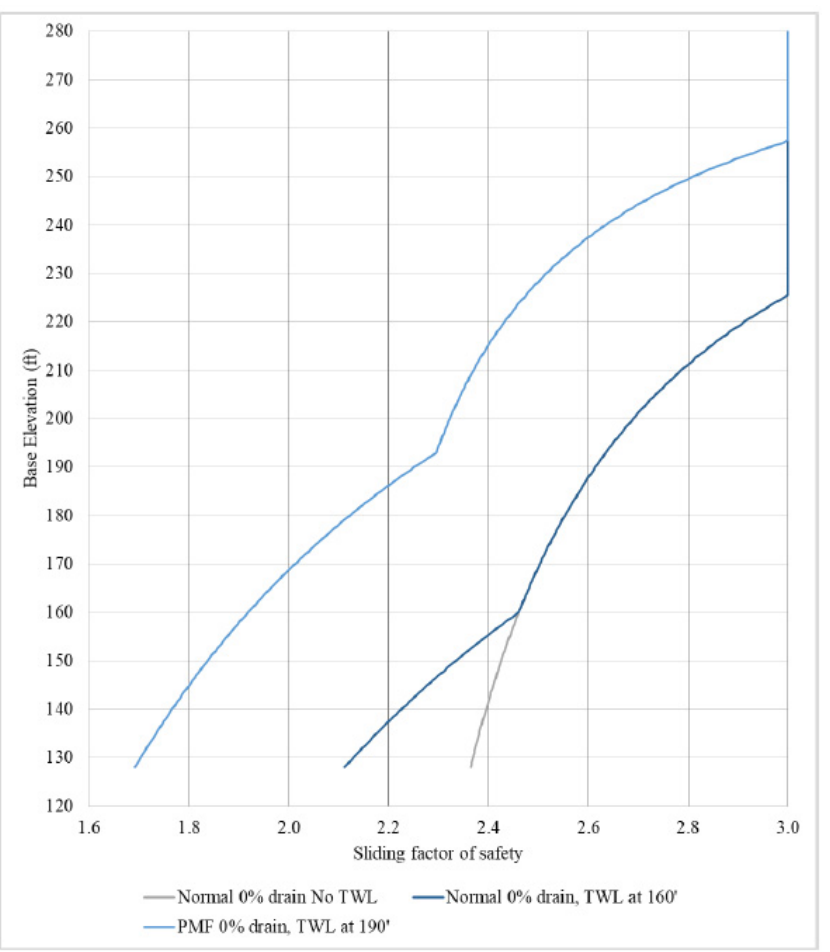
Figure 5. Graphical depiction of gravity analysis results for static loading sliding factor of safety (base friction of 45 degrees).